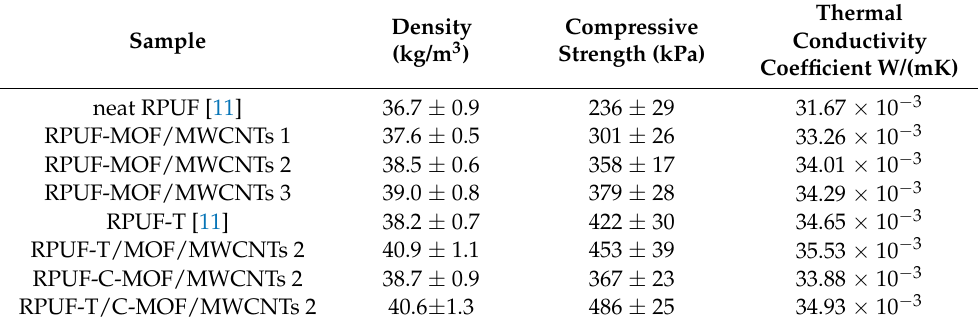
Table 2. Density, compressive strength, and thermal conduction coefficient of RPUFs.